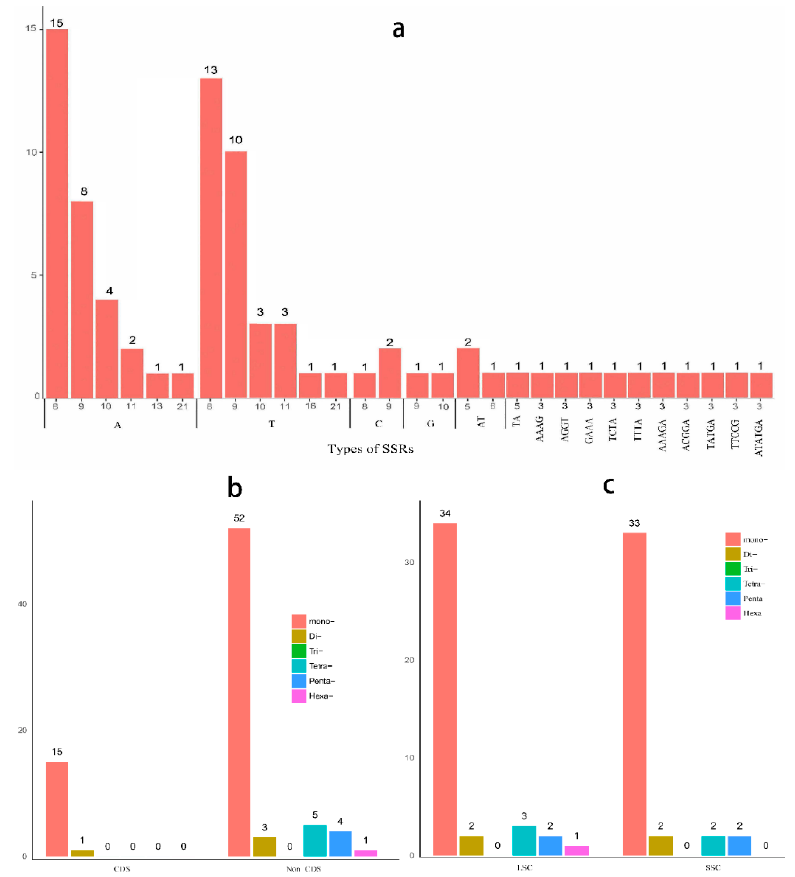
Figure 3. Distribution of each simple sequence repeats (SSR) category in chloroplast genome (CPG) of Pinus massoniana . ( a ) Distribution of each SSR category in whole chloroplast genome; ( b ) Distribution of each SSR category in the coding sequence (CDS) and non-CDS of CPG; ( c ) Distribution of each SSR category in LSC and SSC of CPG.